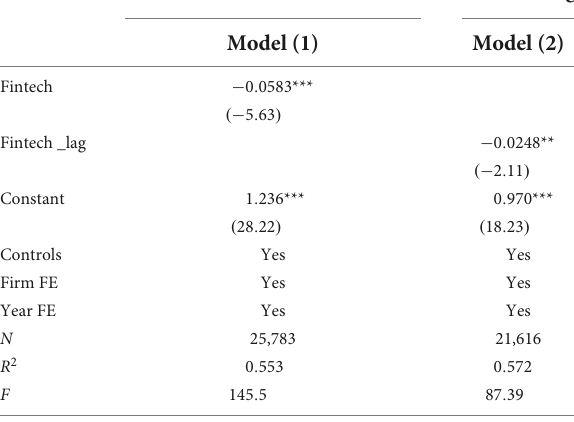
TABLE 9 Channel